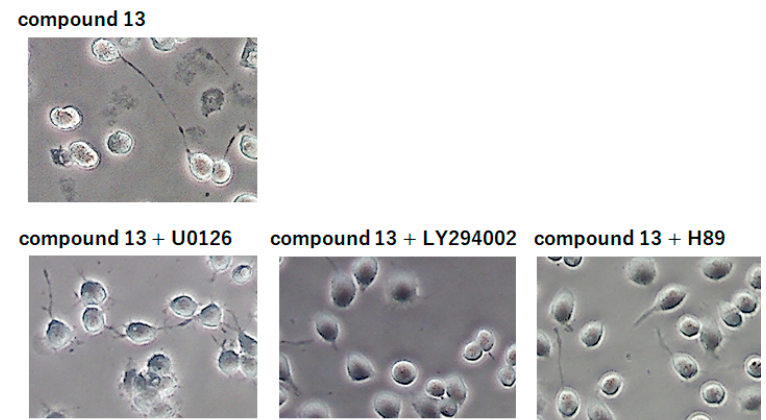
Figure 6. Effects of compound 13 on activation of Akt in neuro2a cells. Neuro2a cells were treated with each inhibitor for 30 min and then incubated with 0.5 µM compound 13 for 48 h.